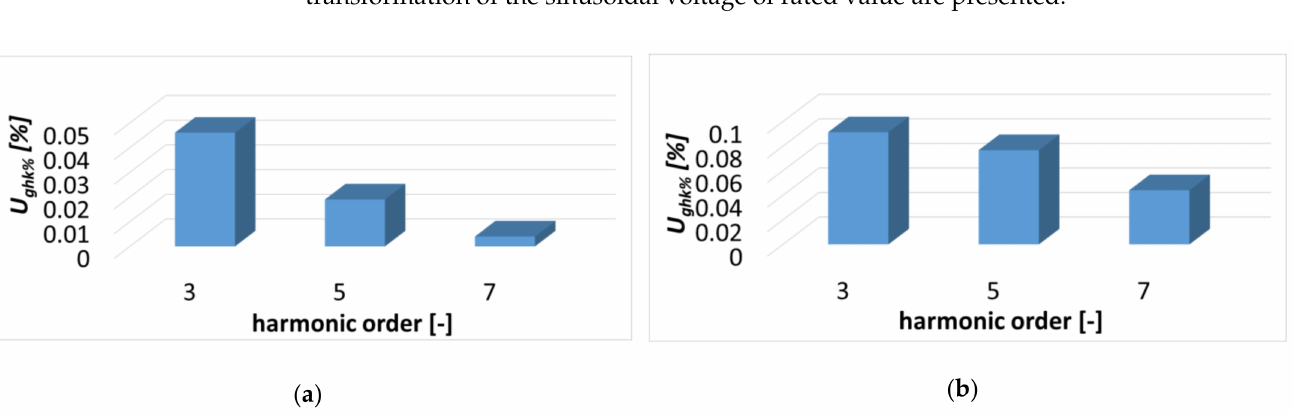
√ √ 3) kV and ( b ) (20/ 3) kV.